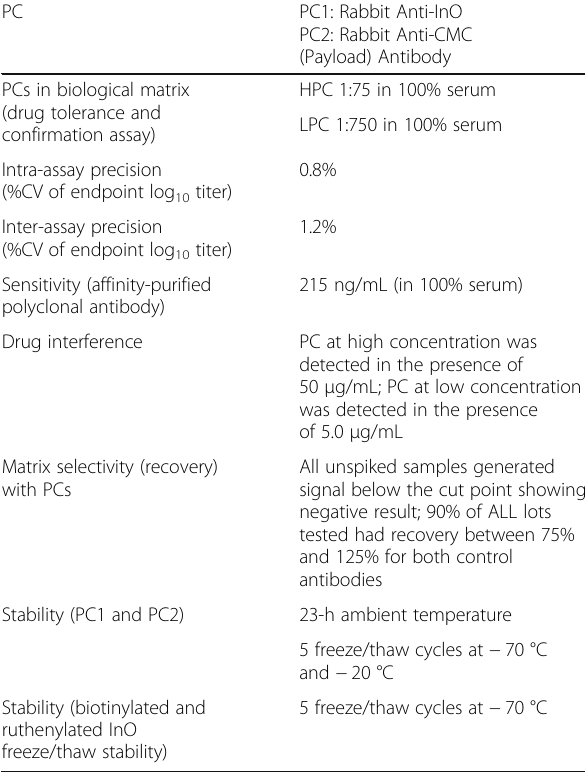
Table 2 Highlights of ECL antibody assay validation